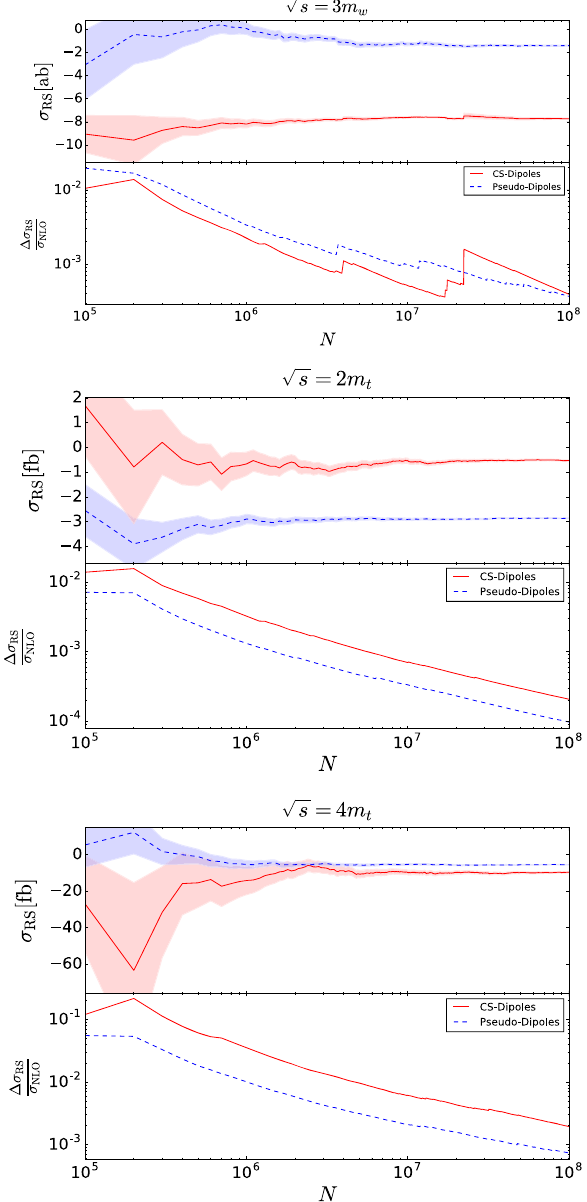
Fig. 10 Evolution of the Monte-Carlo integration results for the sub- tracted real-emission contribution to the total cross section in e + e − → W + W − b ¯ b at varying center-of-mass energy over number of sampled √ √ s = 3 m W , s = 2 m t phase-space points N . From top to bottom: √ s = 4 m t . Red solid lines show results from standard CS-dipoles, and while blue dashed lines correspond to pseudo-dipoles. The colored bands in the upper panels and the lines in the lower panels show the one σ statistical uncertainty of the Monte-Carlo integration